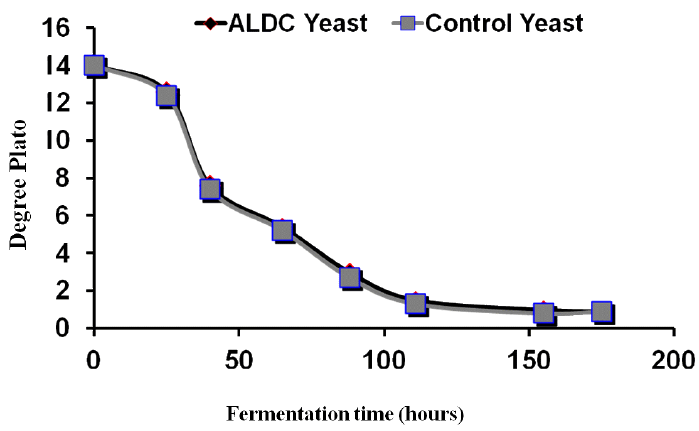
Figure 19. Effect of α -acetolactate decarboxylase (ALDC) expression in a brewing yeast strain on